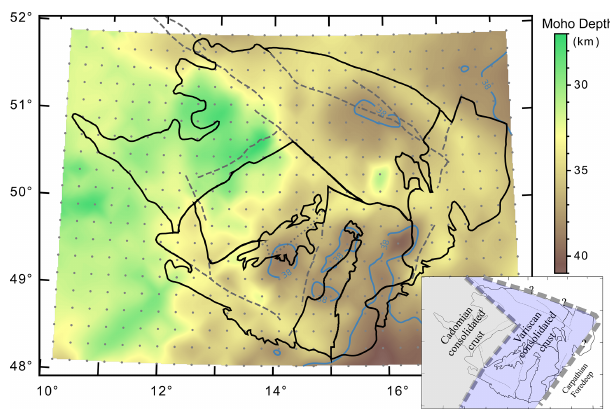
Figure 6. Thickness of the BM crust from ambient noise tomogra- phy. The Moho discontinuity is modelled as the interface between the last sub-layer of the lower part of the crust and the first sub-layer of the uppermost mantle (see Table 1). The Moho depths of 38km are contoured. For standard deviations and skewness coefficients of the Moho depths, see Fig.